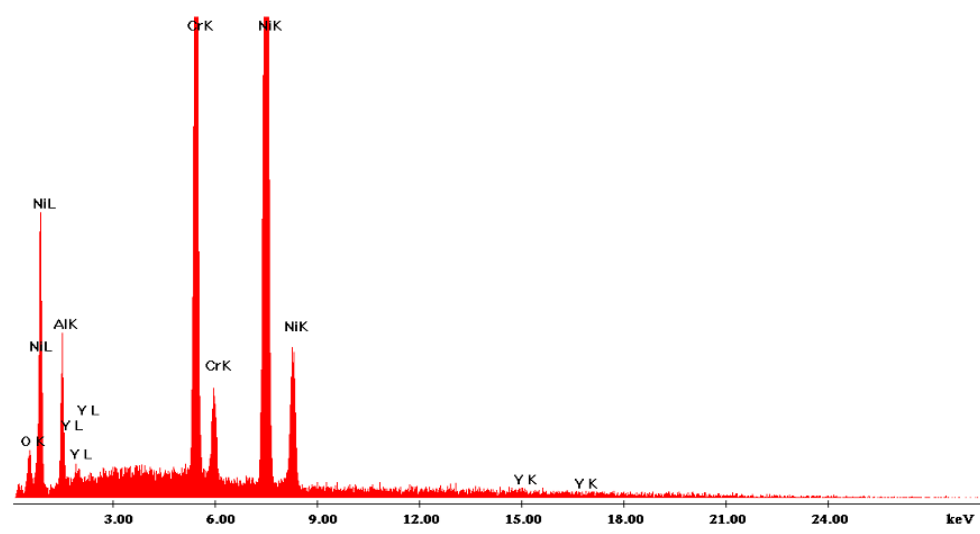
Figure 8. EDS analysis results of the complex 20%Cr10%Al2%Y matrix-line scanning of the processed powder sample in SEM image